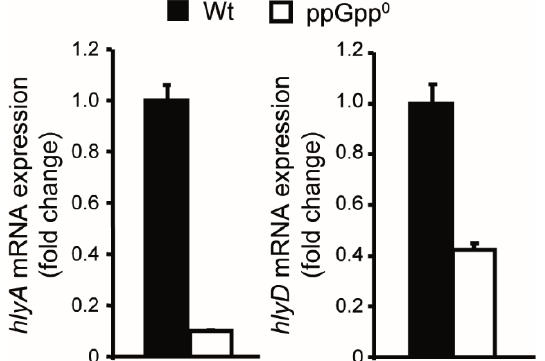
Figure 3. ppGpp stimulates the transcriptional expression of the hlyCABD II operon from J96. Relative hlyA and hlyD mRNA quantification by qPCR in Wt (AAG1) and ppGpp 0 (JFV23) strains carrying plasmid pMGP-1 (pBR322 based plasmid carrying the hlyCABD II operon of J96). RNA samples were extracted from cultures grown in LB at 37 °C up to late exponential phase (OD 600nm of 0.8). The results are mean and the standard deviation from three biological repeats.